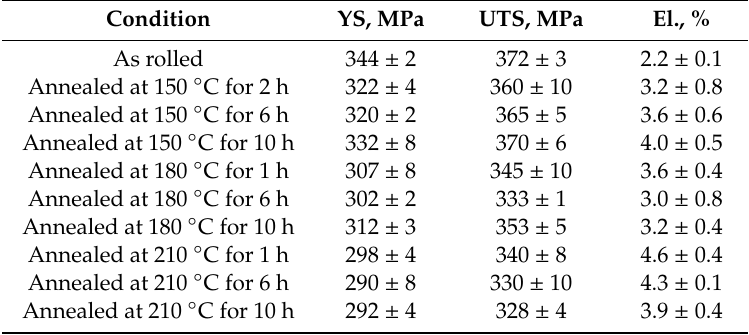
Table 2. Tensile tests results. YS: yield strength; UTS: ultimate tensile